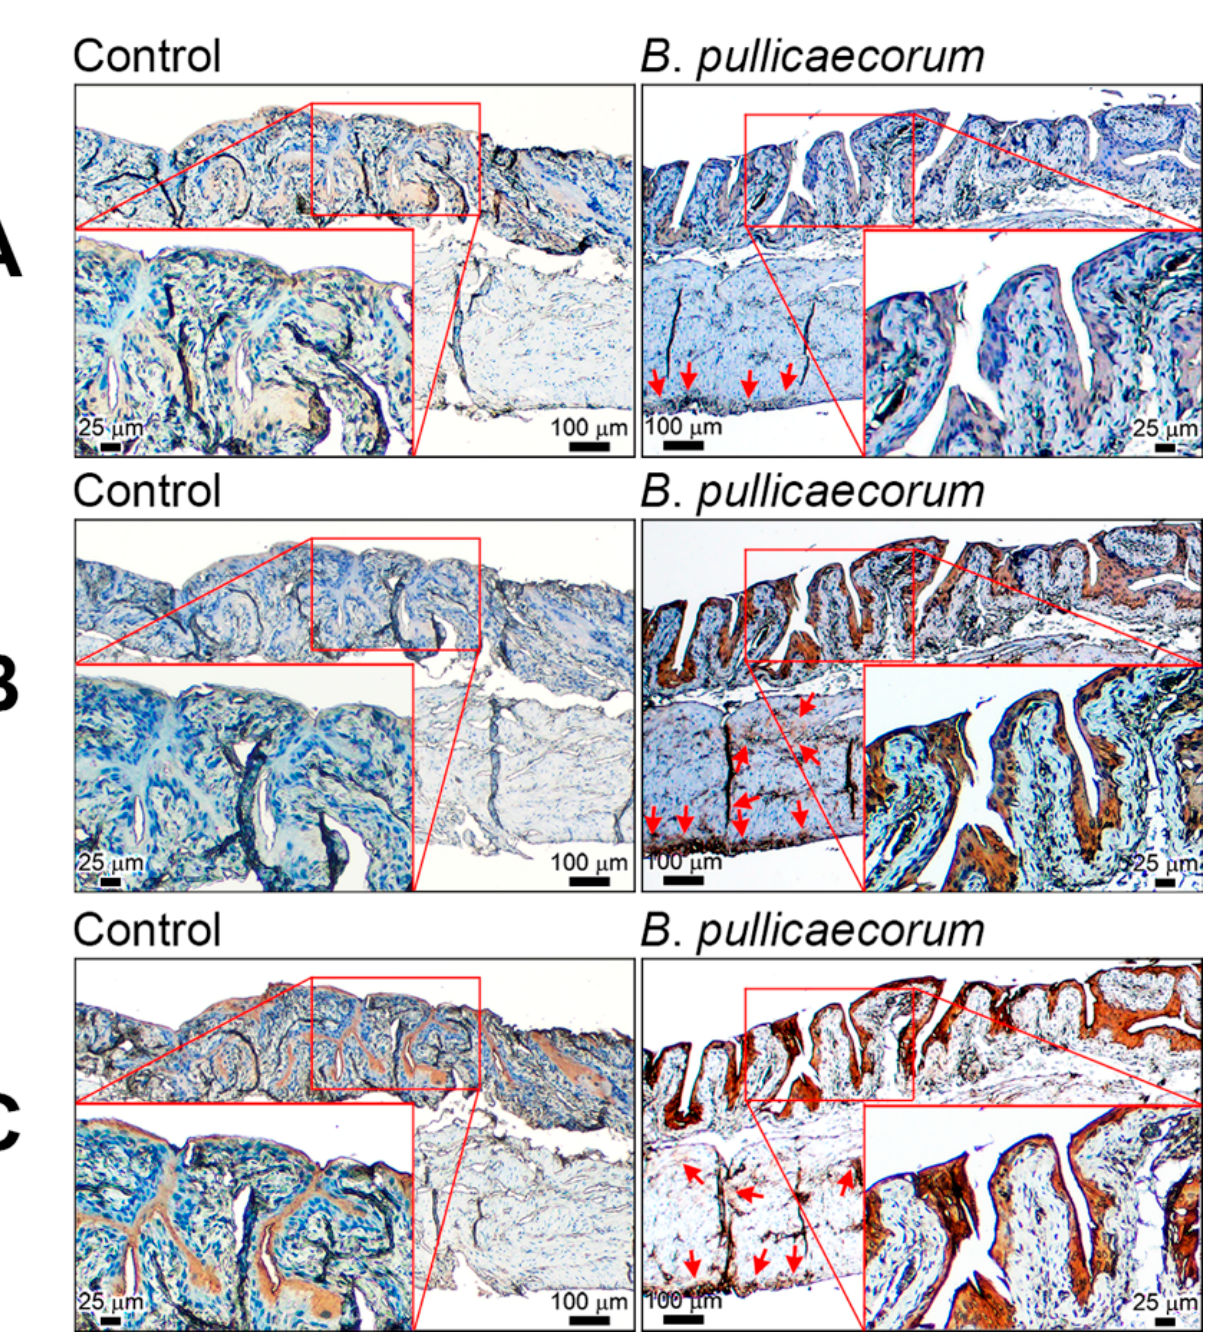
Figure 1. Representative images of SCFA-related gene expression in mouse bladder after B. pullicaecorum administration. ( A ) GPR43 immunohistochemistry staining. ( B ) GPR109B immunohistochemistry staining. ( C ) FABP4 immunohistochem- istry staining. Control mice ( n = 4), without B. pullicaecorum administration; B. pullicaecorum mice ( n = 4), with 1 × 10 7 CFU of B. pullicaecorum administration through anal injection. SCFA, short chain fatty acid.